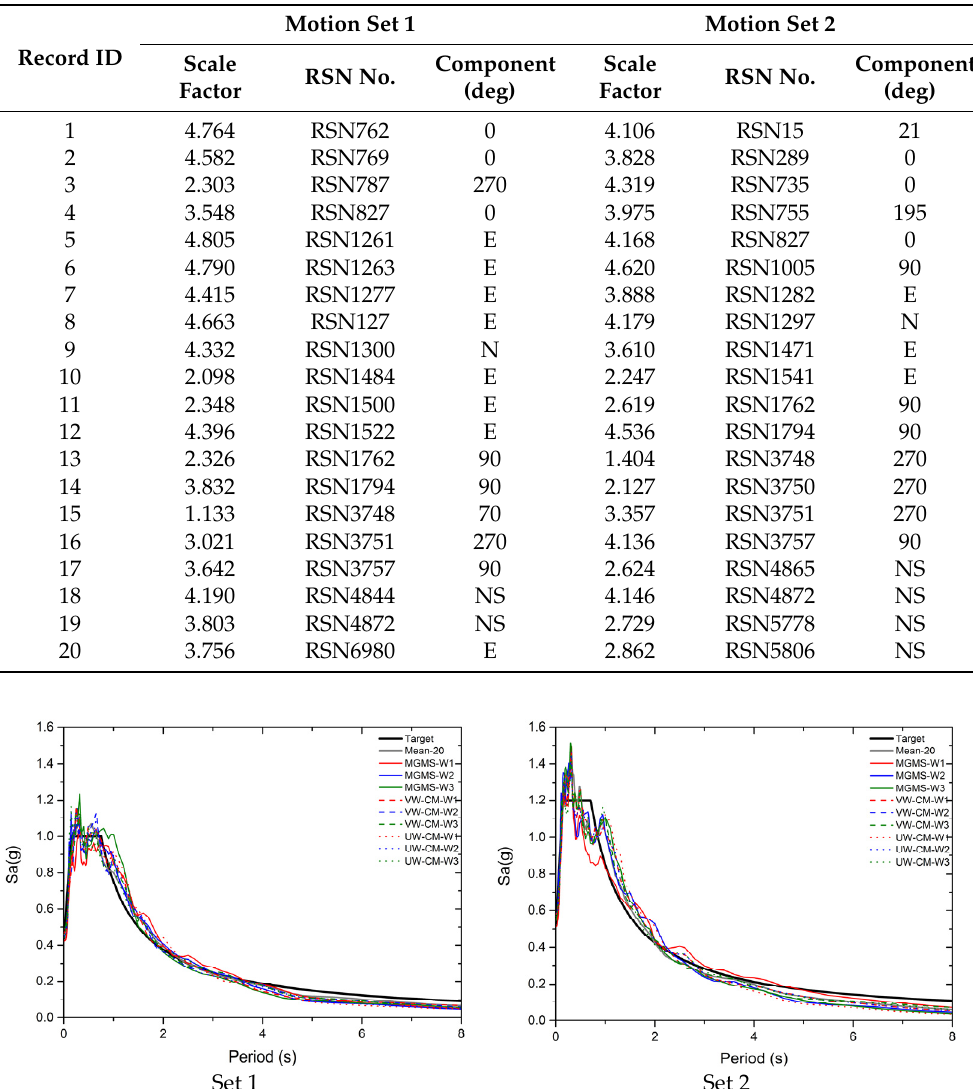
Table A1. Details of IGMs of motion sets 1 and 2.